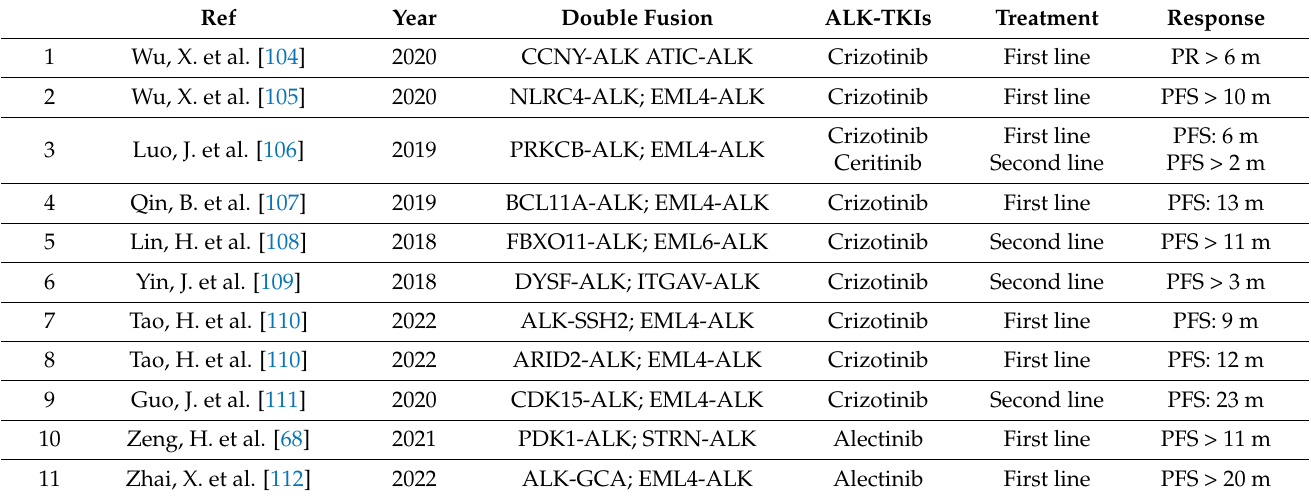
Table 5. Published details of other double ALK fusion positive NSCLC patients treated with